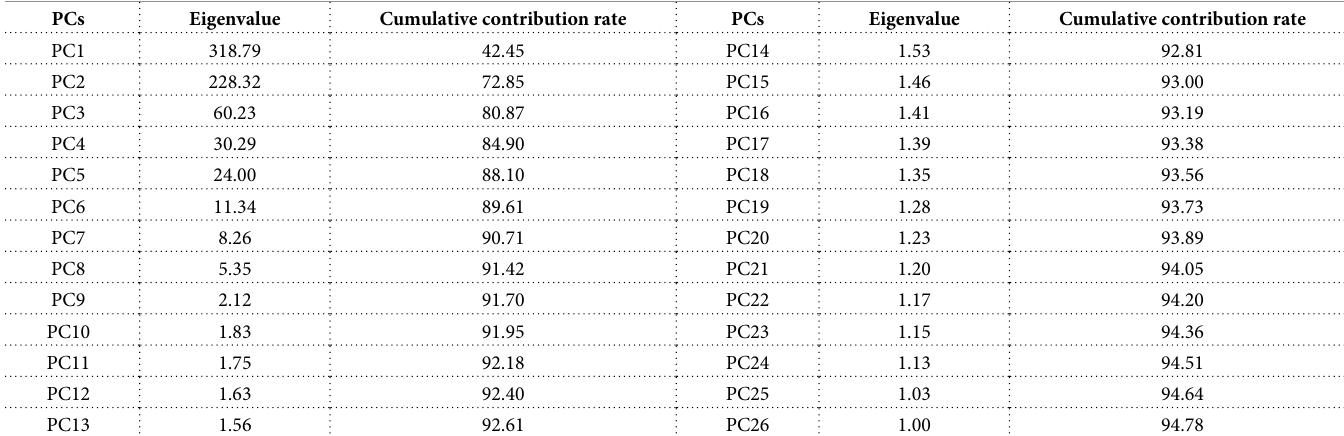
Table 2. Eigenvalues and cumulative contribution rates of effective